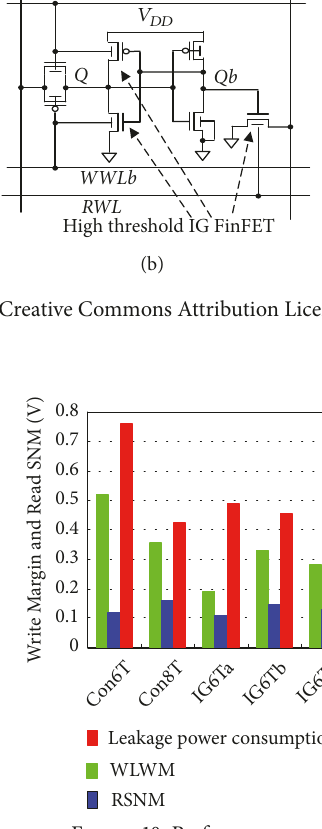
Figure 10: Performance comparison of SRAM